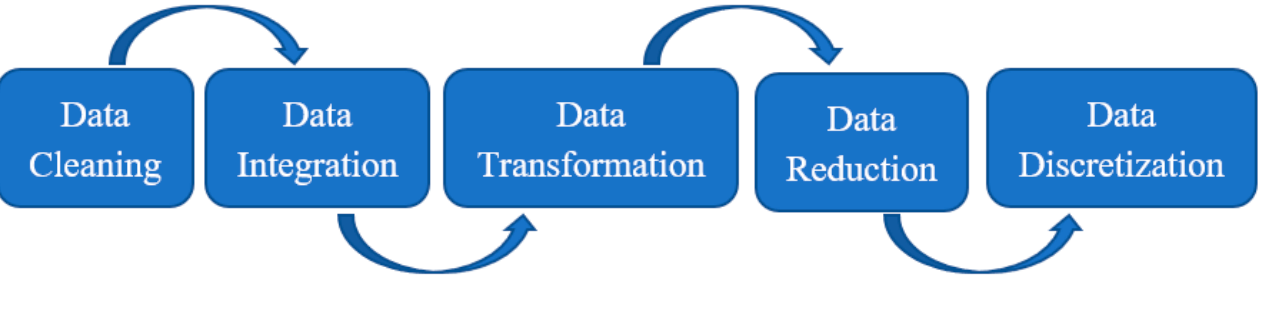
Figure 3. Data pre-processing steps.